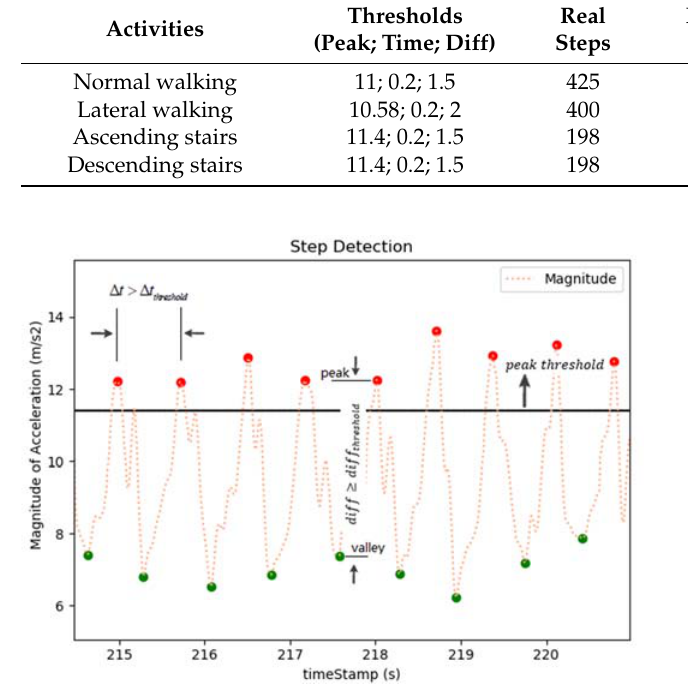
Figure 13. Three thresholds of the peak detection method. Table 9. Details of positioning accuracy assessment for different process strategies.